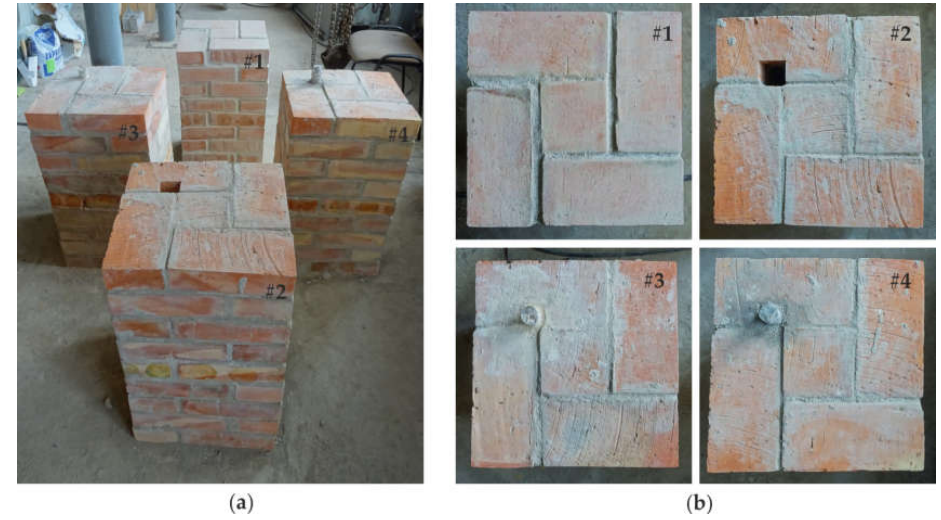
Figure 3. Photographs of laboratory models of the brick pillars: ( a ) overall view; ( b ) plane views of specimens #1 to #4 .